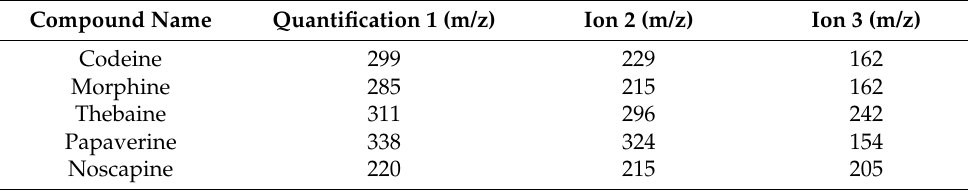
Table 1. Retention time and m/z values of fragment ions selected for the quantification and confir- mation of the five opium